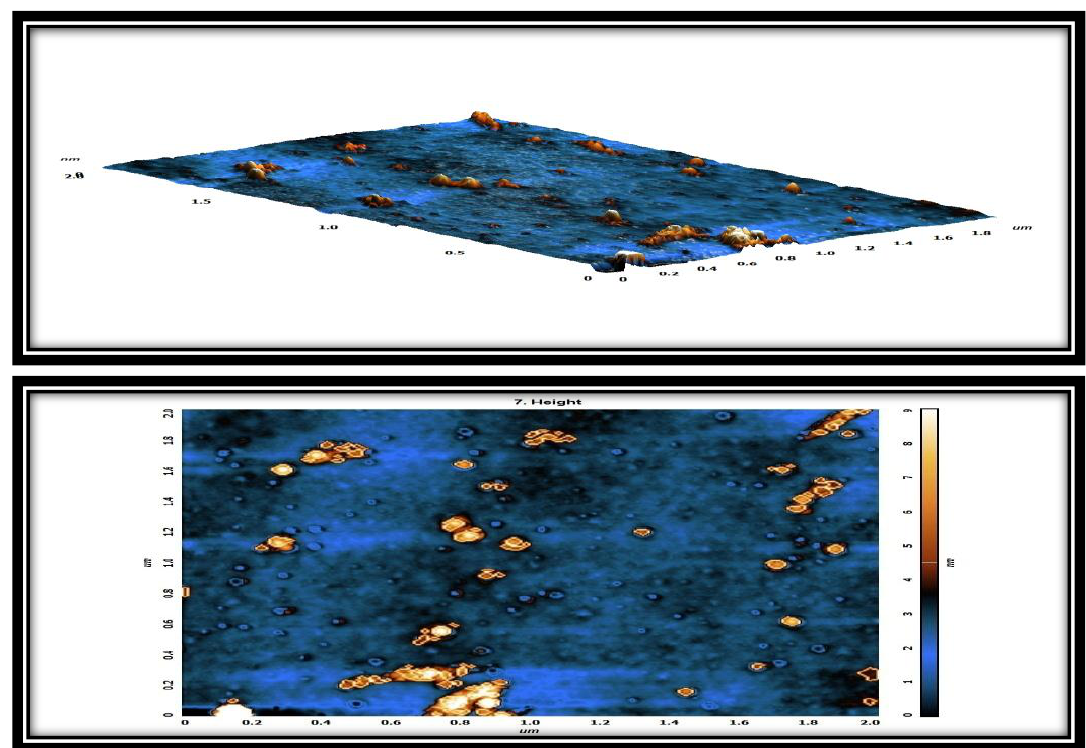
Figure (11): Atomic force microscopy of formula F21 showing cross section and long tudinal section of the nanoparticles surface.